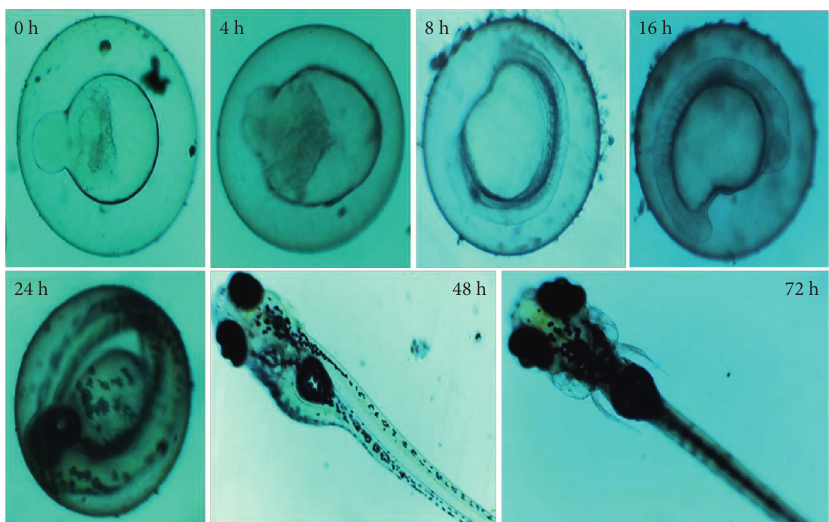
Figure 13: Zebrafish embryo hatching, viability, and hatching delay in zebrafish